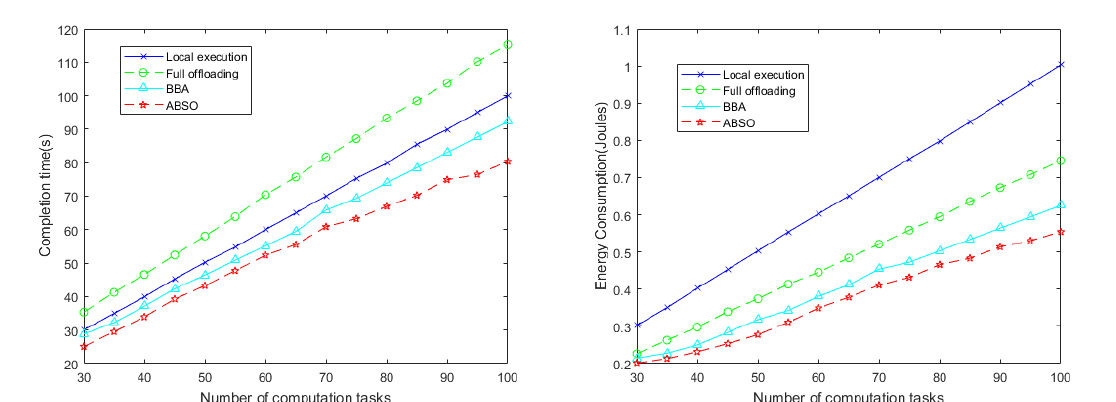
Figure 4. Energy consumption of mobile devices and completion time of tasks under various quantities of computation tasks.